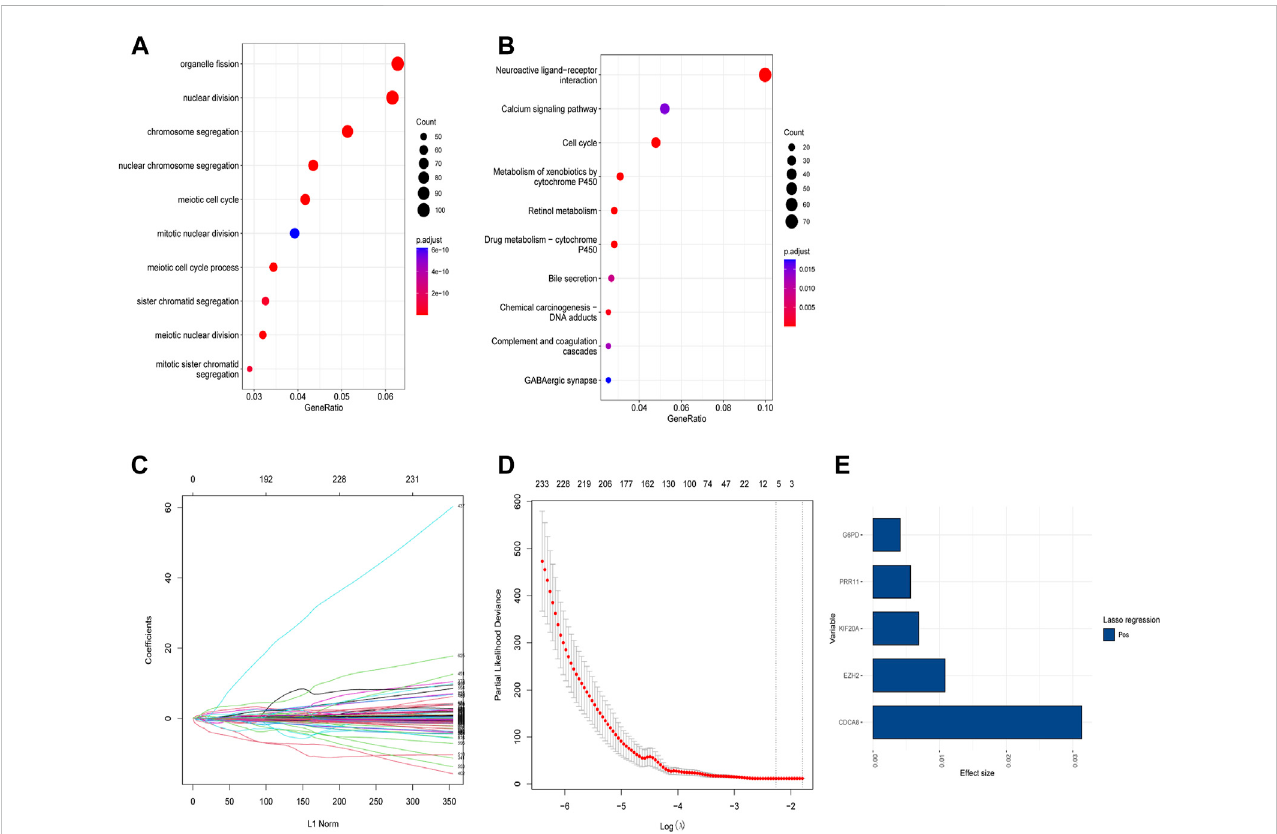
FIGURE 5 Functional analysis of different subtypes and the construction of cuproptosis-related genes (CRGs) signature in hepatocellular carcinoma. (A) Gene ontology(GO)enrichmentanalysisresultsinthetwoCRGssubtypes. (B) KyotoEncyclopediaofGenesandGenomes(KEGG)enrichmentanalysisresultsinthe two CRGs subtypes: (C) Lasso regression coef fi cients of each variable with L1 norm; (D) Lambda logarithm value in Lasso regression and the relationship with the error (the dotted line is the range that Lambda can choose); (E) The coef fi cient values of the Lasso regression screening